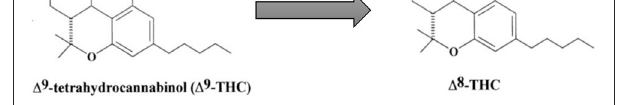
FIGURE1 Conversion of 1 9 -THC to 1 8 -THC. Adapted with permission from Elsevier, Mechoulam, R. and L. Hanuš (2002). “Cannabidiol: an overview of some chemical and pharmacological aspects. Part I: chemical aspects.” Chemistry and physics of lipids 121(1-2): 35-43.